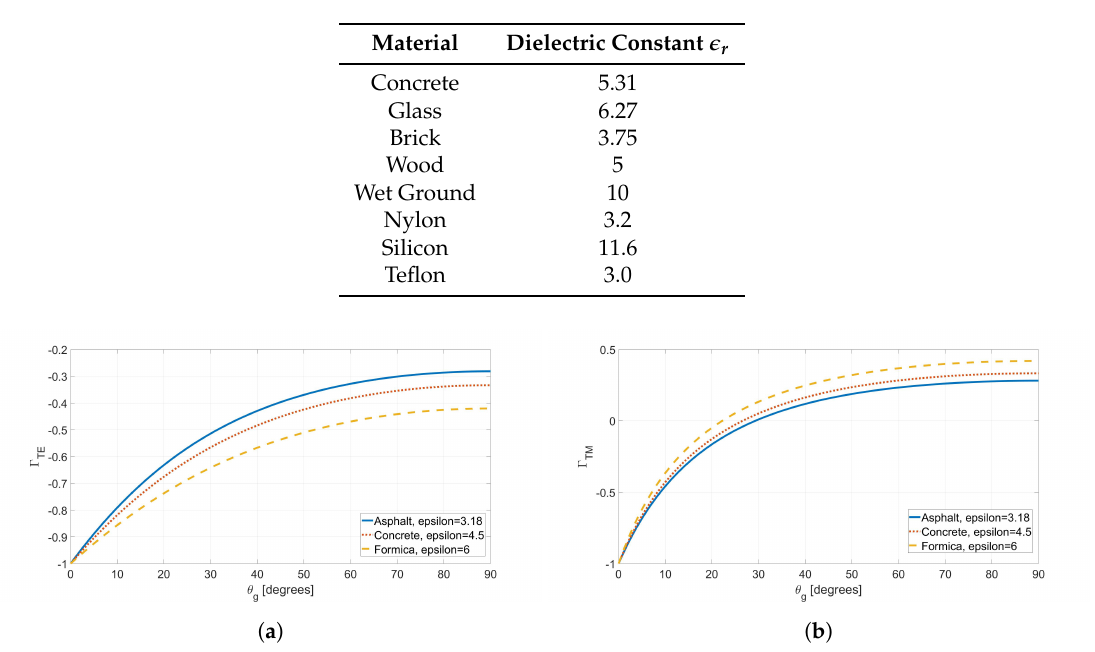
Table 2. Relative dielectric coefficients of construction materials at 28 GHz.